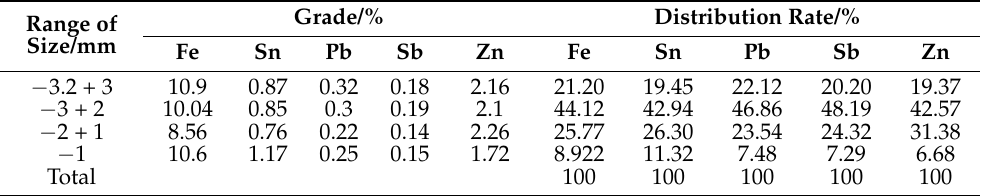
Table 3. The analysis results of the main metal element in each size. Range of Size/mm